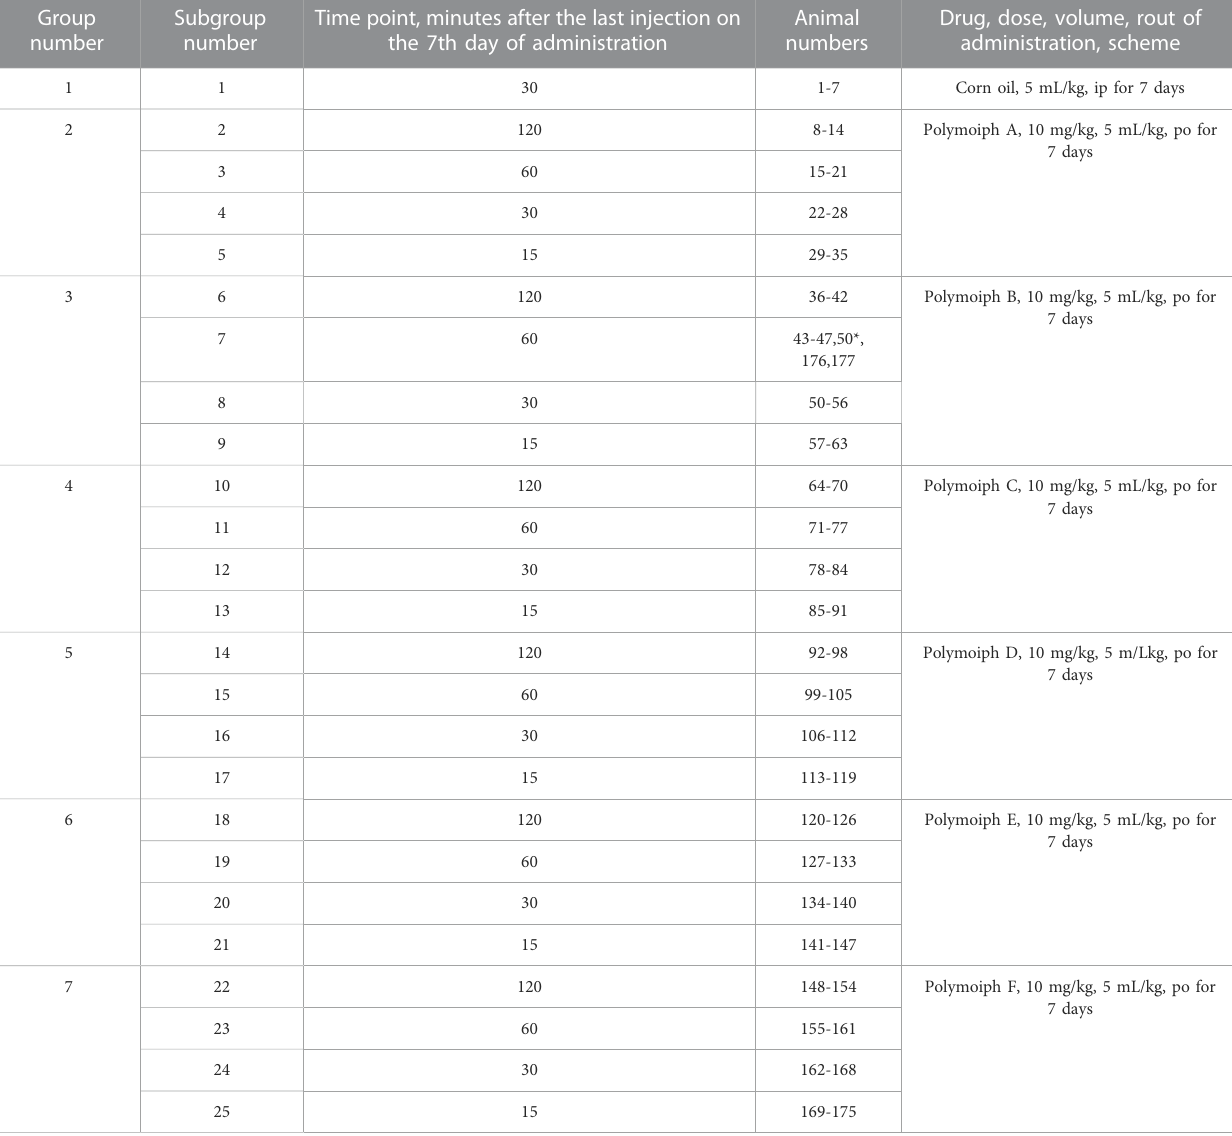
TABLE 1 Groups and doses (pharmacokinetics). Group